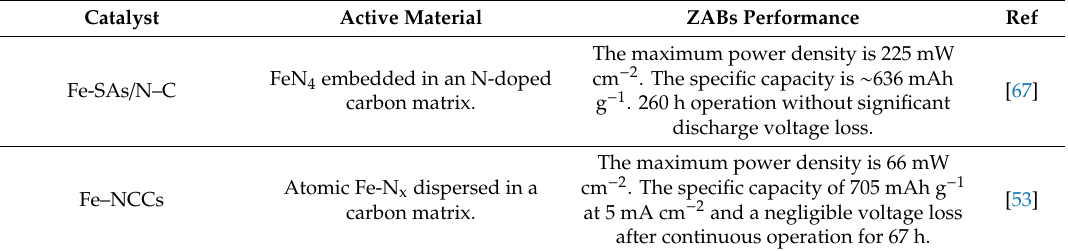
Table 1. Performance of ZABs using the recent representative SACs.